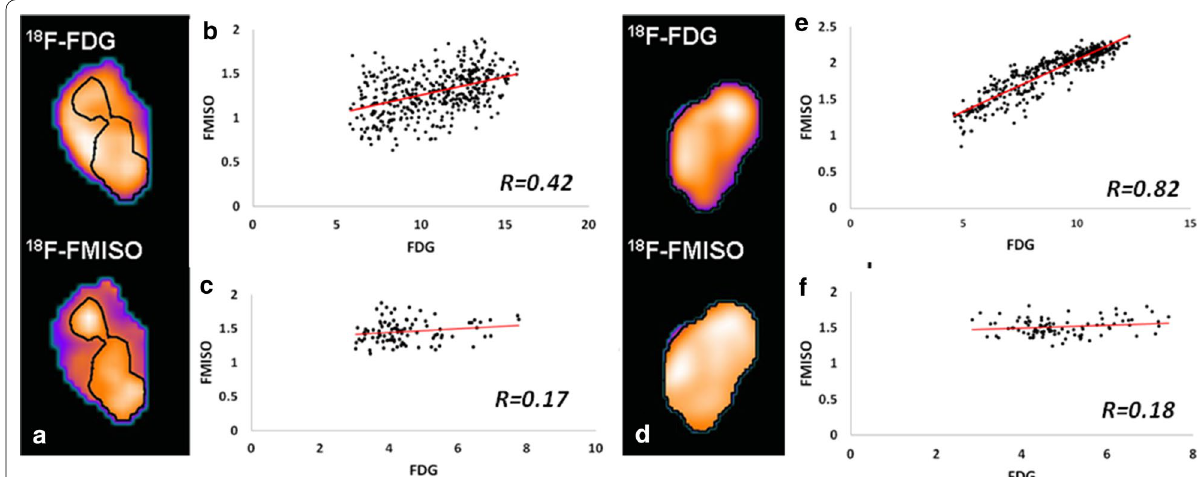
Fig. 1 Example of FDG-SUV vs FMISO-SUV scattergrams for a b low correlation lesion, R (pt# 16). Figures a , d are the corresponding FMISO and FDG coronal images; the black contour refers to the HV satisfying a FMISO T/B > 1.2. For reference, FDG vs FMISO scattergrams for normal brain tissue regions are shown in figures c , f for the two patients,